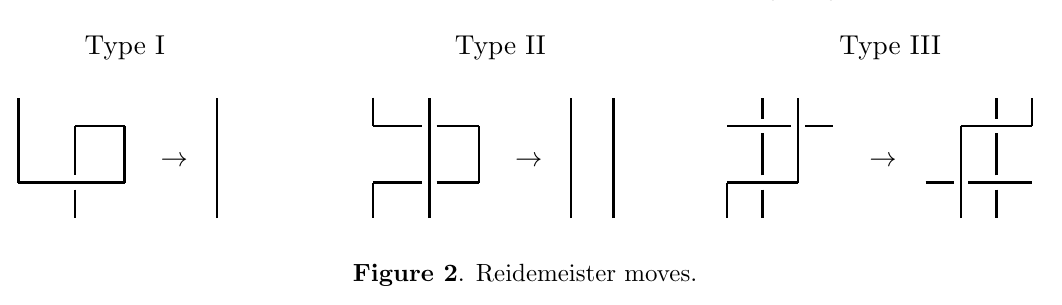
Figure 2 . Reidemeister